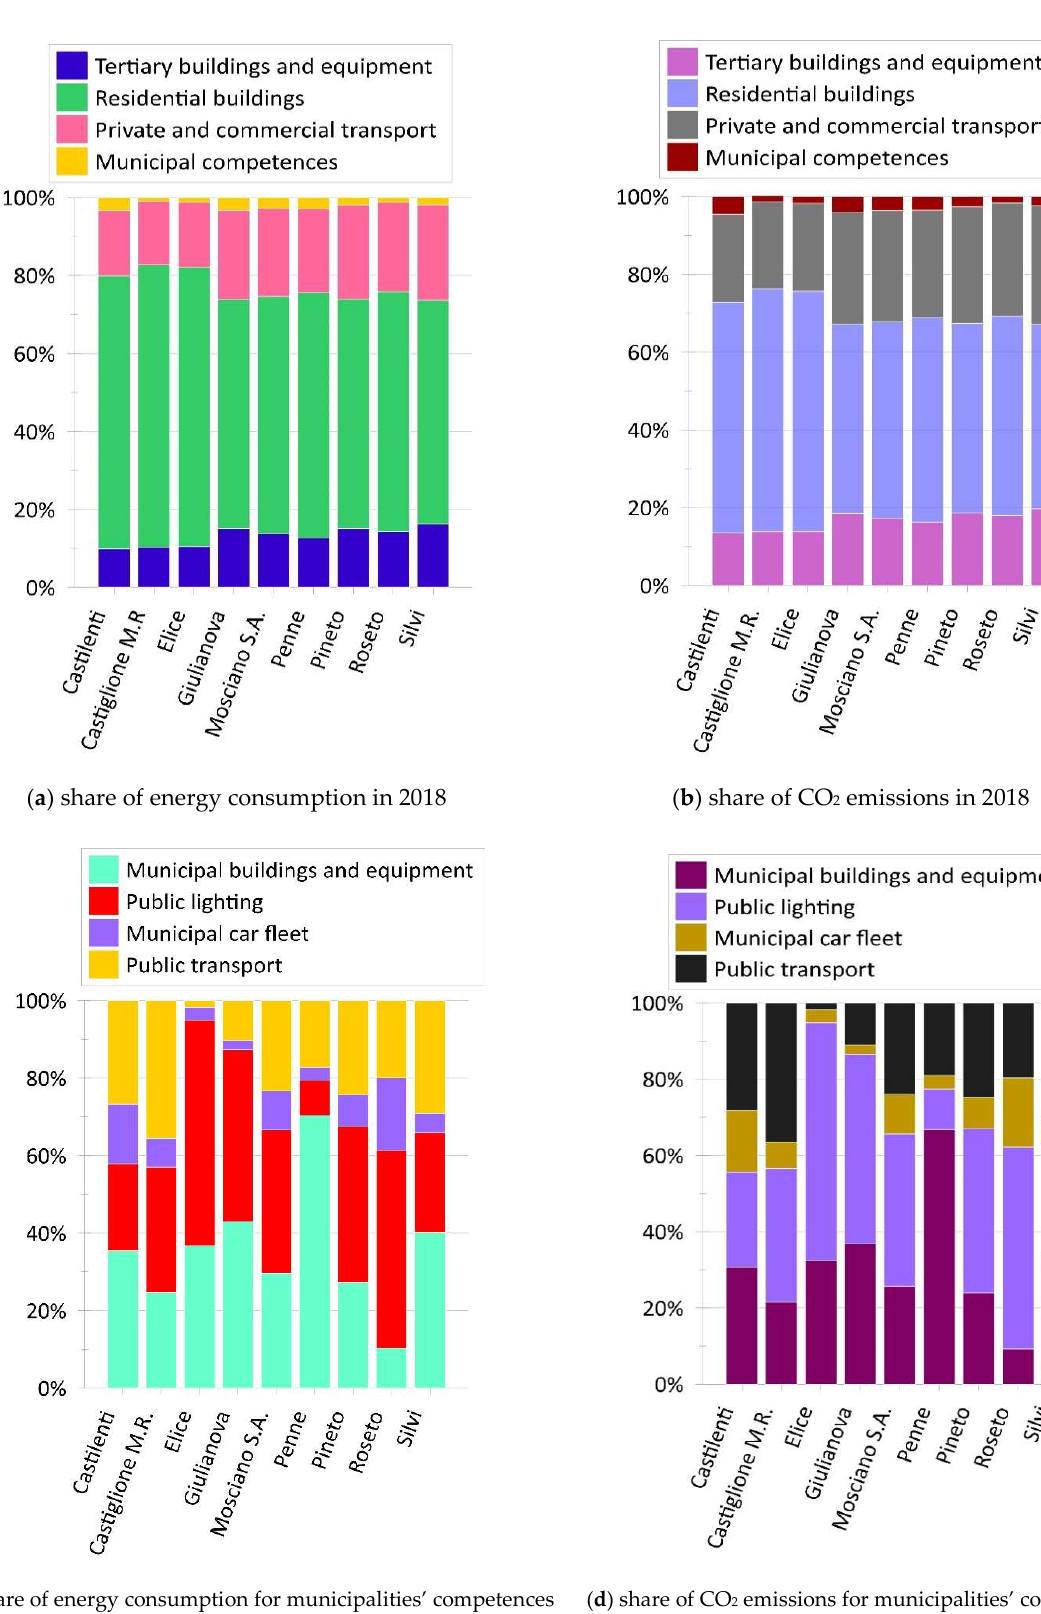
Figure 3. Percent share of consumption ( a , c ) and emissions ( b , d ) for each municipality. In ( c , d ) the specific consumption and emissions in the municipality competences sector are reported.